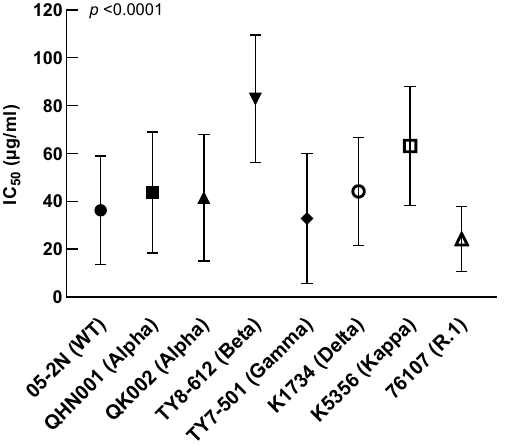
Figure 3. Antiviral activity of IgG antibodies in convalescent plasma against wild-type and each variant. Data are mean ± standard deviation.